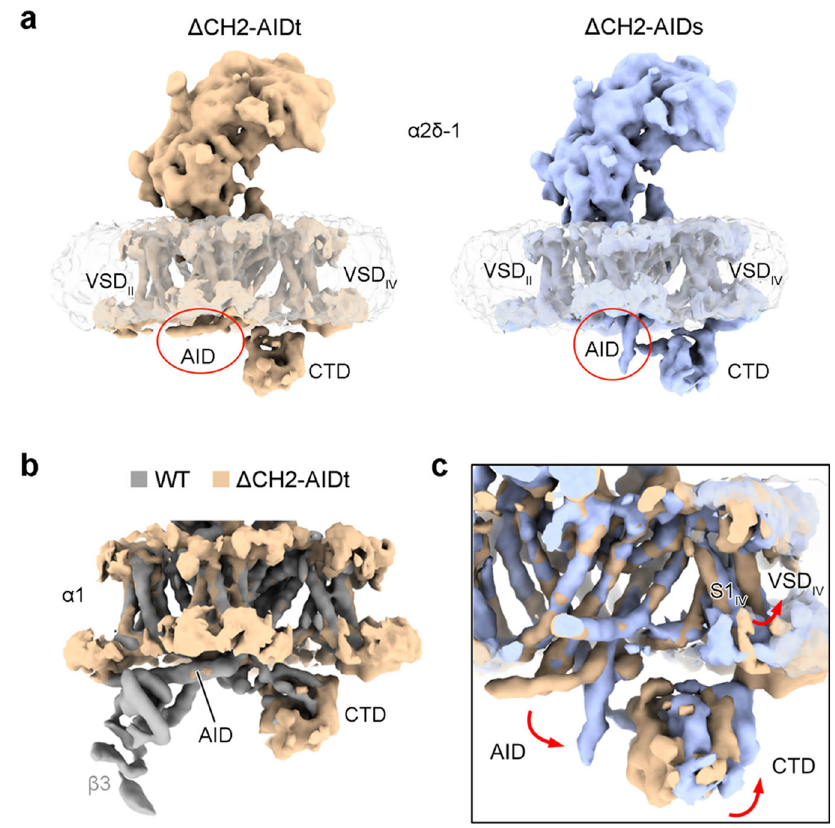
Fig. 5 | 3D variability analysis (3DVA) of Δ CH2 mutant Ca v 2.3. a Two extreme trajectories from 3DVA reveal a “ transverse ” AID (1 st frame, designated as Δ CH2- AIDt) versus a “ straight ” AID (10 th frame, designated as Δ CH2-AIDs). These two reconstructionsarelow pass- fi ltered to 7Å. b The α 1 subunit in Δ CH2-AIDt (wheat)